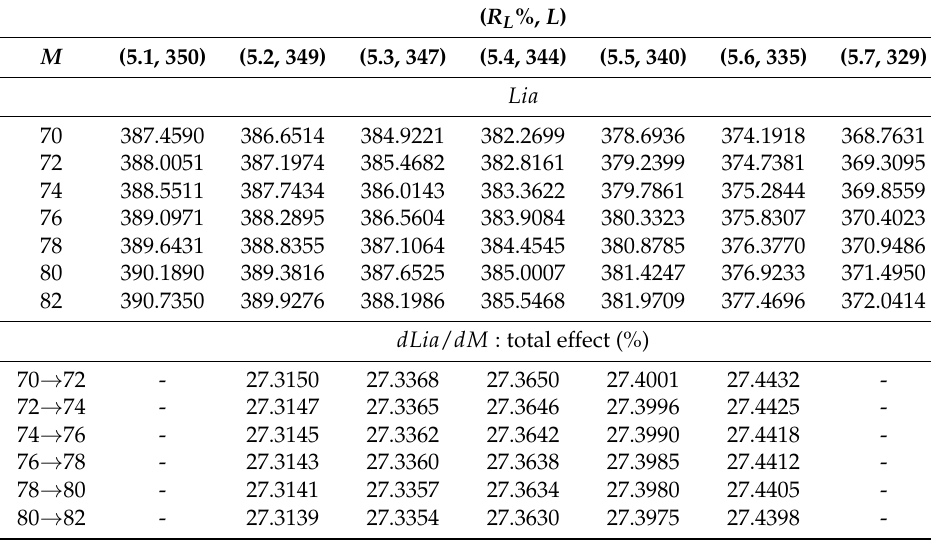
Table 5. Responsiveness of the bank’s liabilities to WMPs 1